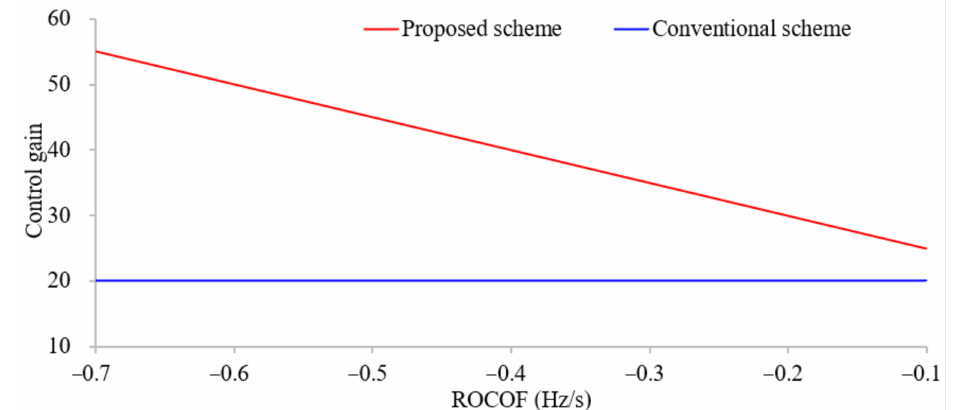
Figure 3. Comparison of proposed and conventional droop coefficients.